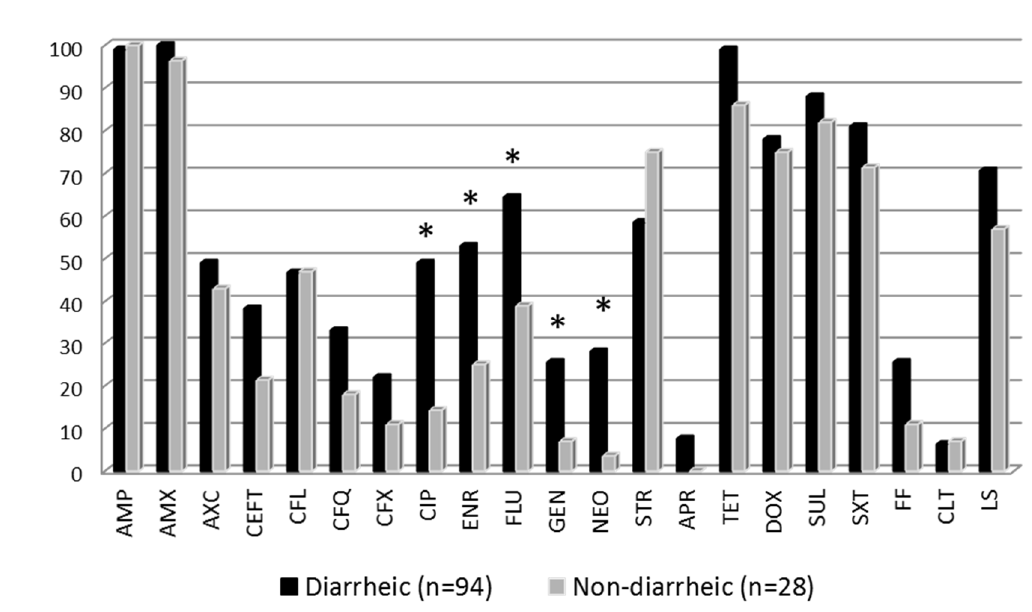
Figure 1. Antimicrobial resistance of E. coli strains from diarrheic and non-diarrheic groups. * Statistical differences between diarrheic and non-diarrheic animals (Fisher exact test p < 0.05). Antibiotic abbreviations are shown in Table 1.